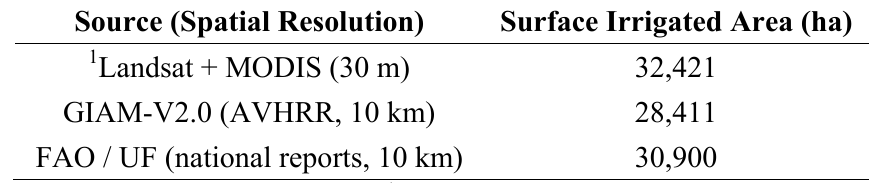
Table 5. The map of irrigated area of Ghana was compared with other studies such as GIAM (global irrigated area map) version 2.0 [44] and